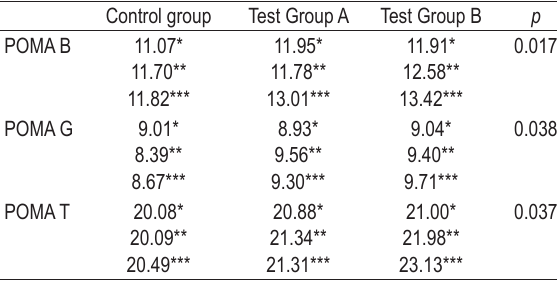
TABLE 6. Average values of POMA through three measurements